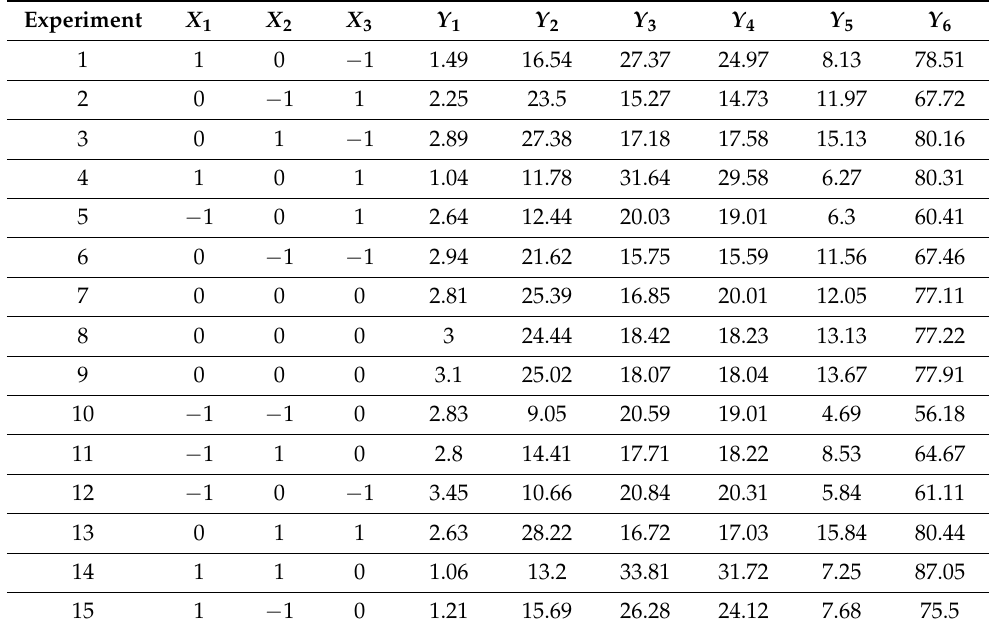
Table 4. Box–Behnken design